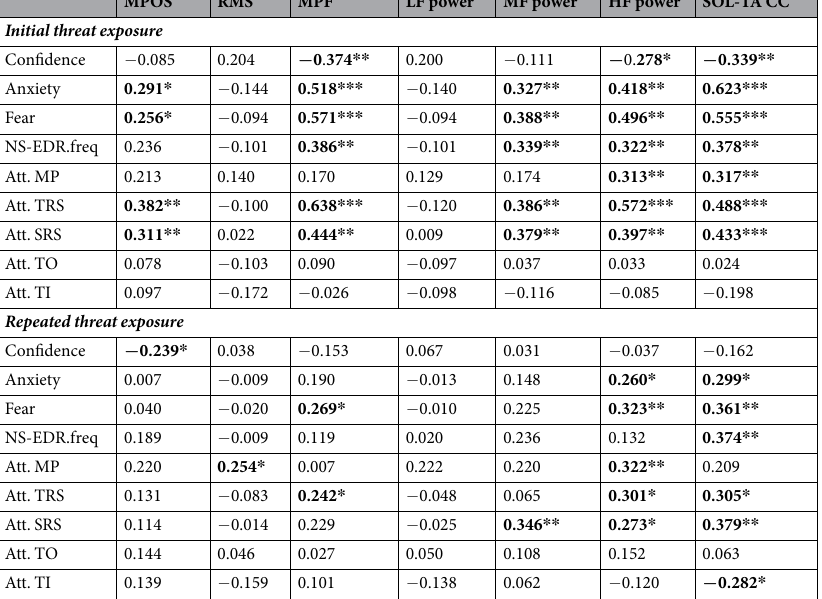
Table 3. Bivariate correlations between emotional and cognitive and behavioural outcomes when initially threatened and after repeated threat exposure. Note . Variables reflect change scores (Initial threat exposure = HIGH1-LOW1; Repeated threat exposure = HIGH5-HIGH1). NS-EDR.freq = non-specific electrodermal response frequency; Att. = attention toward; MP = movement processes; TRS = threat-related stimuli; SRS = self-regulatory strategies; TO = task objectives; TI = task-irrelevant information; MPOS = mean position of centre of pressure; RMS = root mean square of centre of pressure; MPF = mean power frequency of centre of pressure; LF power = low frequency centre of pressure power; MF power = medium frequency centre of pressure power; HF power = high frequency centre of pressure power; SOL-TA CC = soleus-tibialis anterior co-contraction. * p < 0 . 05; ** p < 0 . 01; *** p < 0 . 001